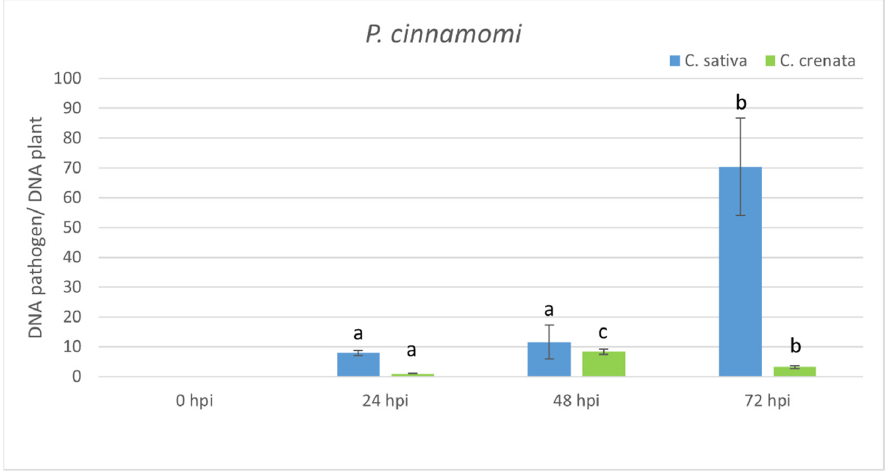
Figure 4. qRT-PCR pathogen DNA quantification after P. cinnamomi inoculation. Data were quantified using the 2 −ΔΔ Ct method based on the Ct values of pathogen genes (ypt and mf1) and actin-7 as a housekeeping gene. Data are the means of three biological replicates ± SE. C. sativa data are normalized with C. sativa 0 hpi control; C. crenata data are normalized with C. crenata 0 hpi control. Different letters associated with the set of means indicate a significant difference based on Tukey’s HSD test ( p ≤ 0.05).